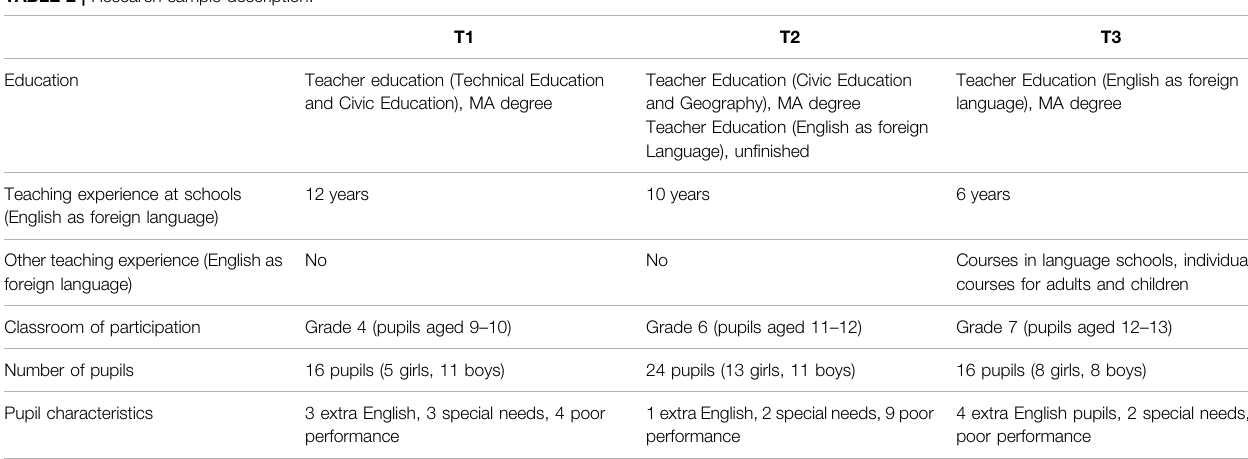
TABLE 2 | Research sample